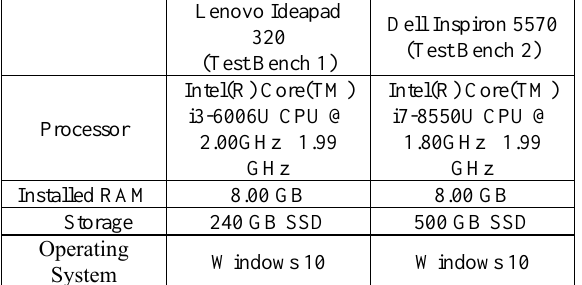
Table 6. Laptop Specifications.